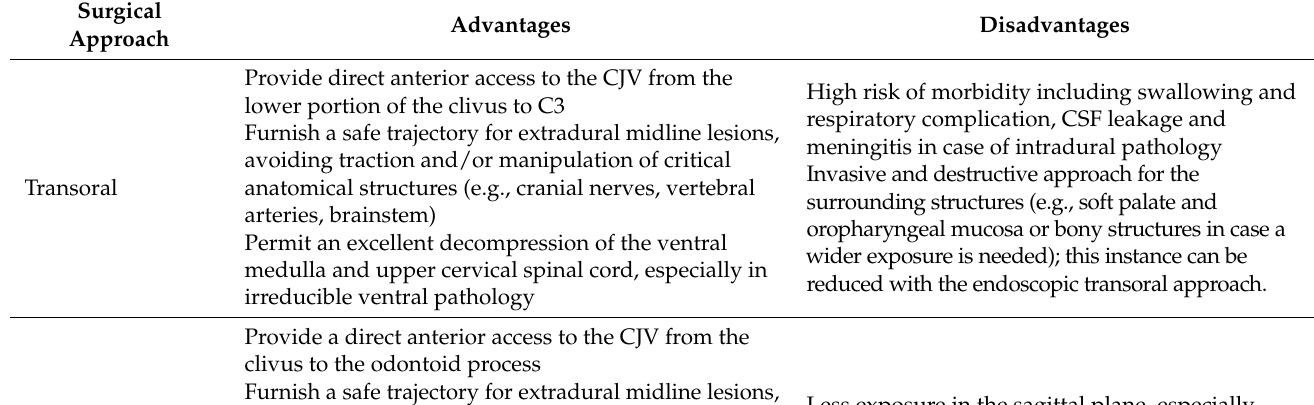
Table 1. Advantages and disadvantages for each surgical